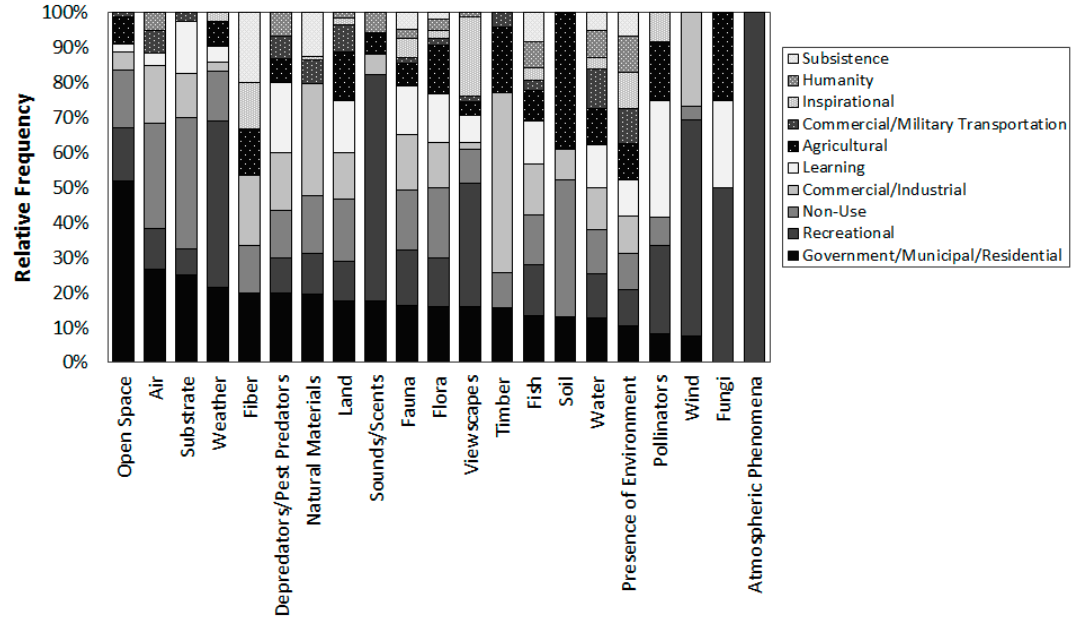
Figure 6. Relative frequency by which documents linked each type of FEGS to different types of Beneficiaries.